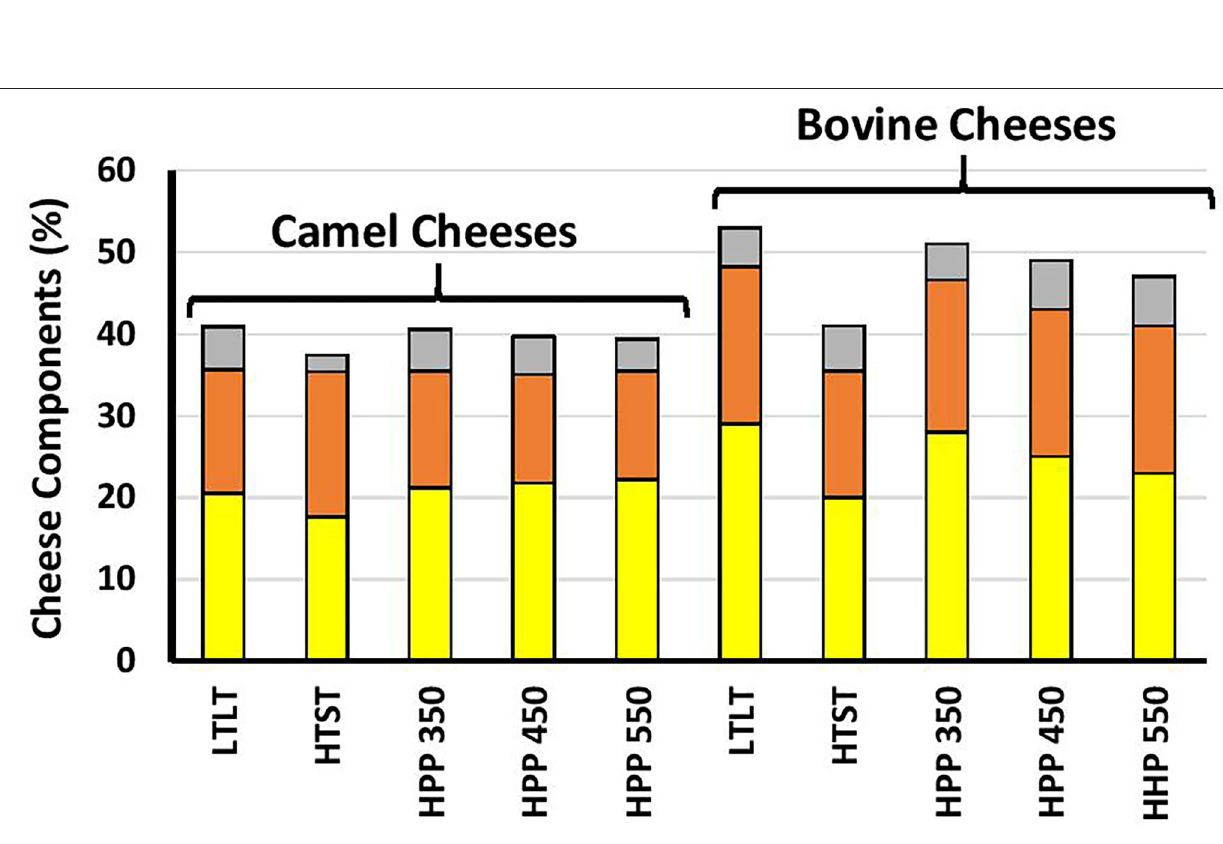
Frontiers in Nutrition |